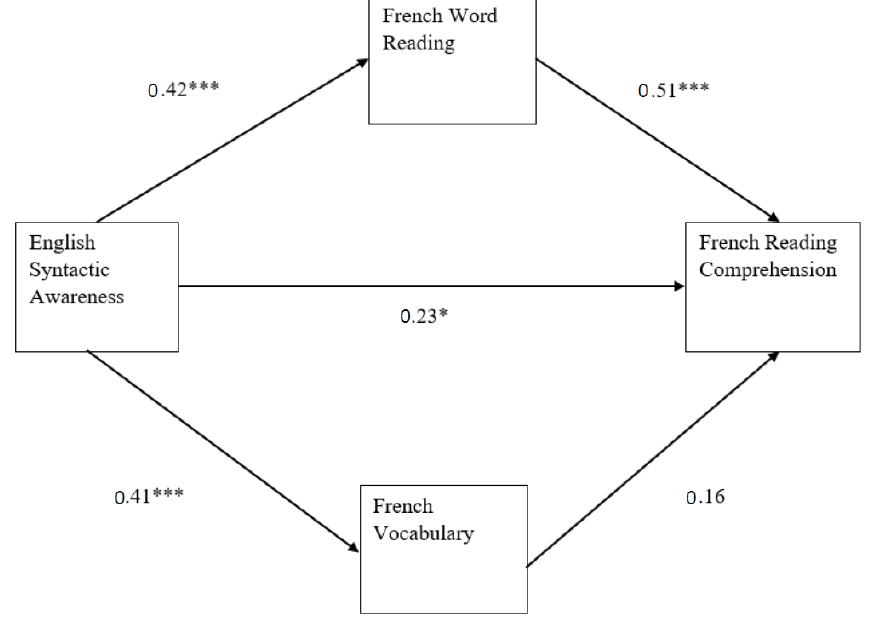
Figure 2. The cross-language model with standardized coefficients. *** p < 0.001; * p < 0.05. All coefficients are standardized.